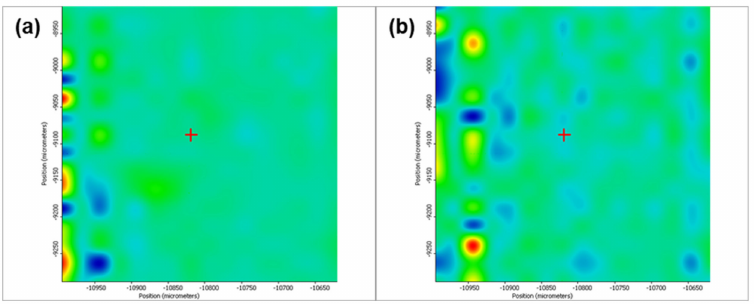
Figure 6. Second derivate IR mappings of Fe 3 O 4 @ β -CD thin films deposited at F = 300 mJ/cm 2 : surface intensity distribution of ( a ) 2930 cm − 1 and ( b ) 1029 cm − 1 .